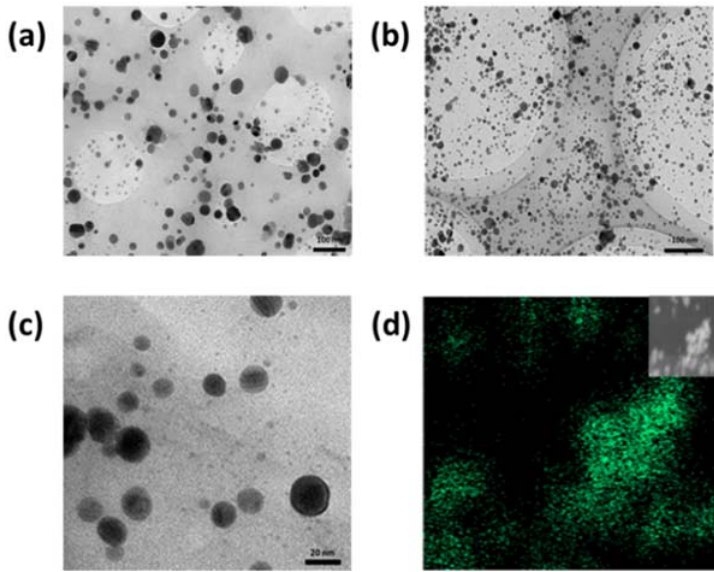
Figure 1. TEM micrographs of ( a ) GO-Ag and ( b ) GOCOOH-Ag, ( c ) magnified image of GOCOOH-Ag, and ( d ) EDS mapping of AgNPs deposited on the GOCOOH surface.